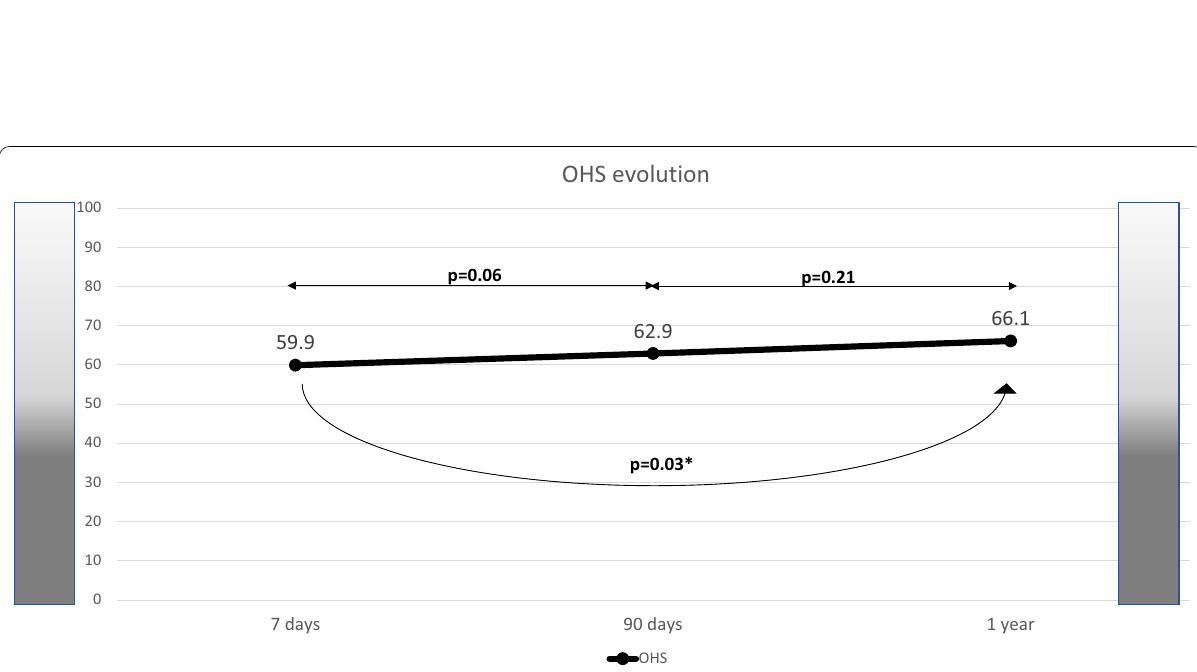
Fig. 6 Mean of overall health status (OHS) at the different time‑points of measurement (7 days, 90 days and one year after stroke). Range: 0 (worst perception of health status)–100 (best perception of health status). Thin arrows represent statistical comparison of the rate of favorable/unfavorable outcomes as compared with the previous time‑point. *Statistically